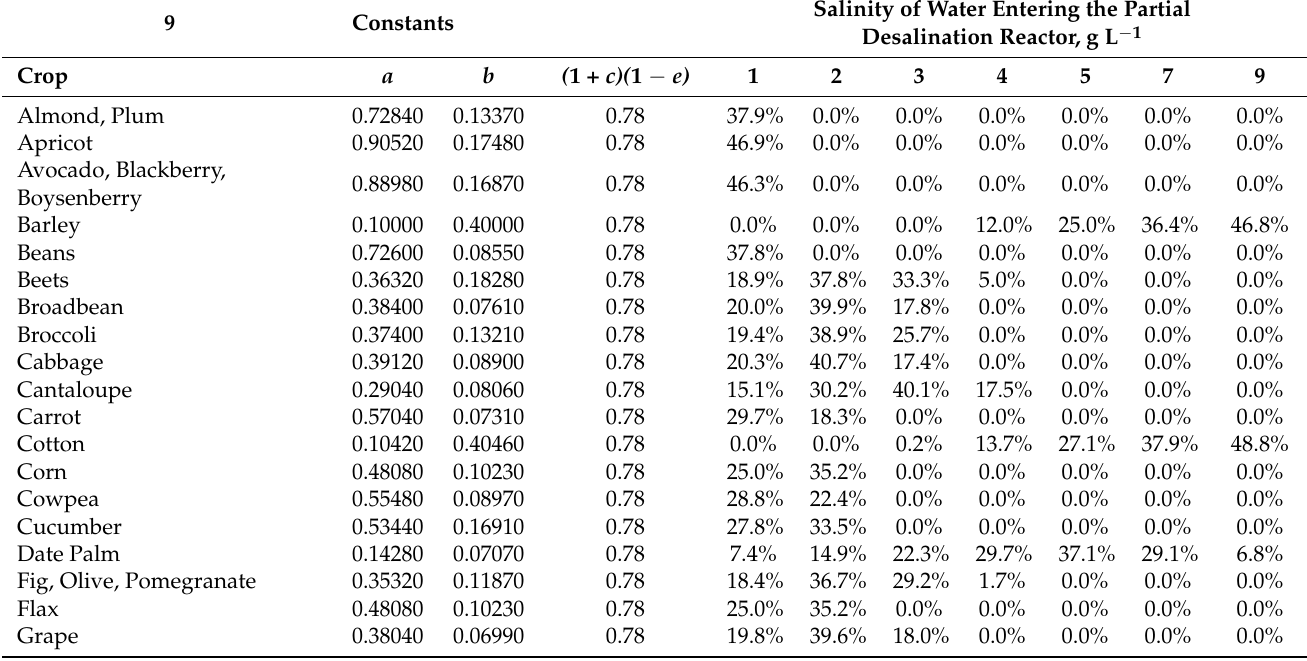
Table A6. Proportion of expected crop yield with freshwater irrigation (Table A4), added by irri-gating with partially desalinated water. Calculated as Results in Table A5—Results in Table